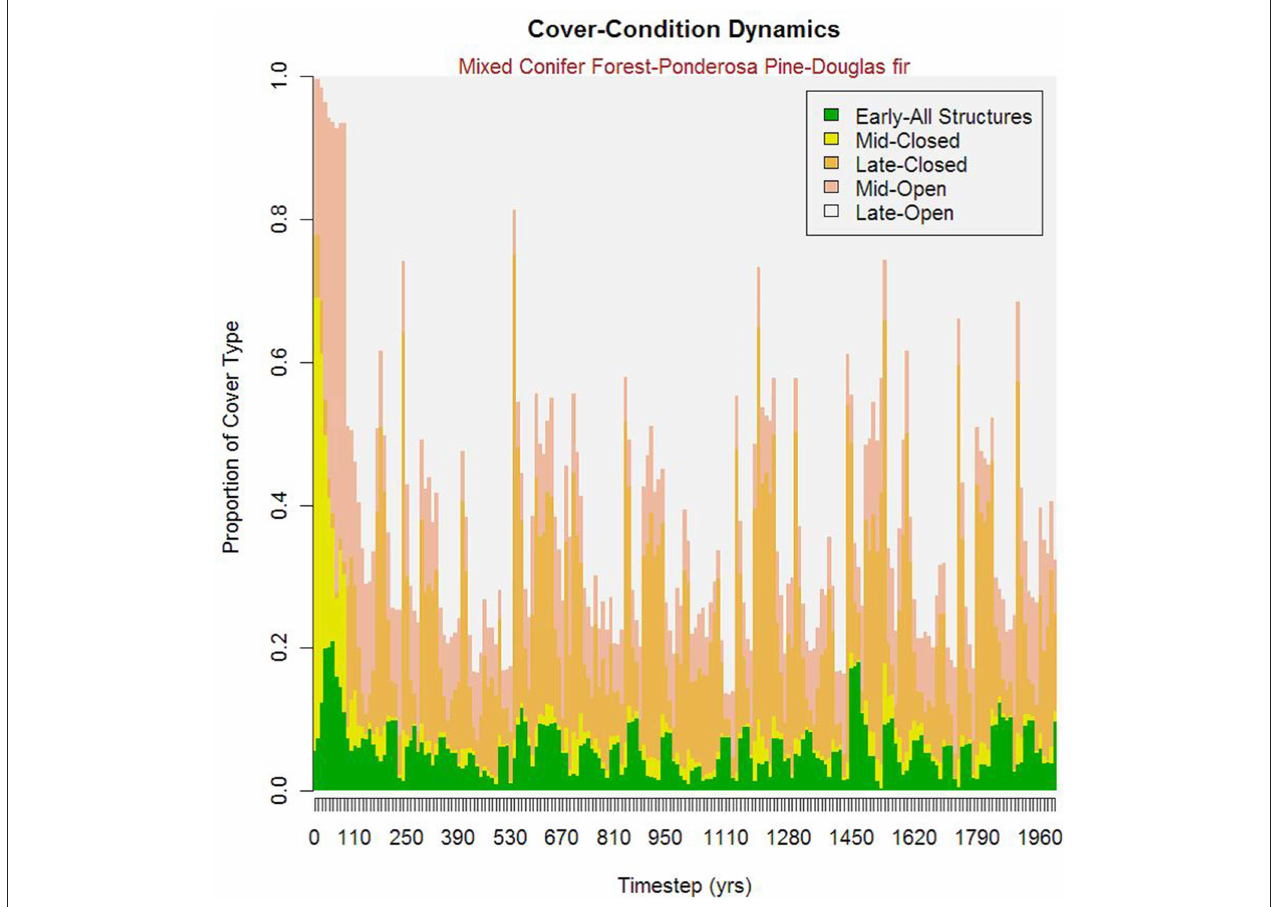
FIGURE 4 | Temporal plot of proportion of the Prospect Creek landscape covered by each of the different seral stages for one focal vegetation cover type, Mixed Conifer Forest - Ponderosa Pine-Douglas